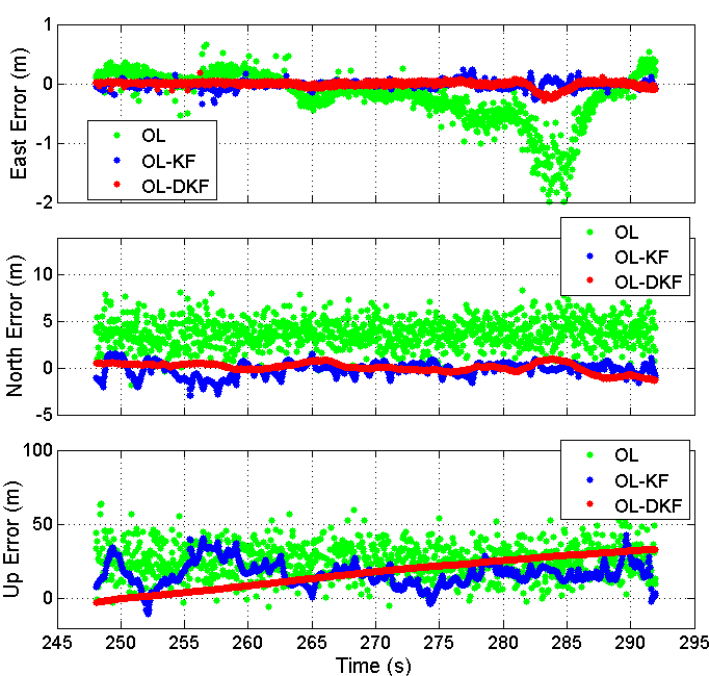
Figure 19. Three-dimensional errors of the unblocked road test.